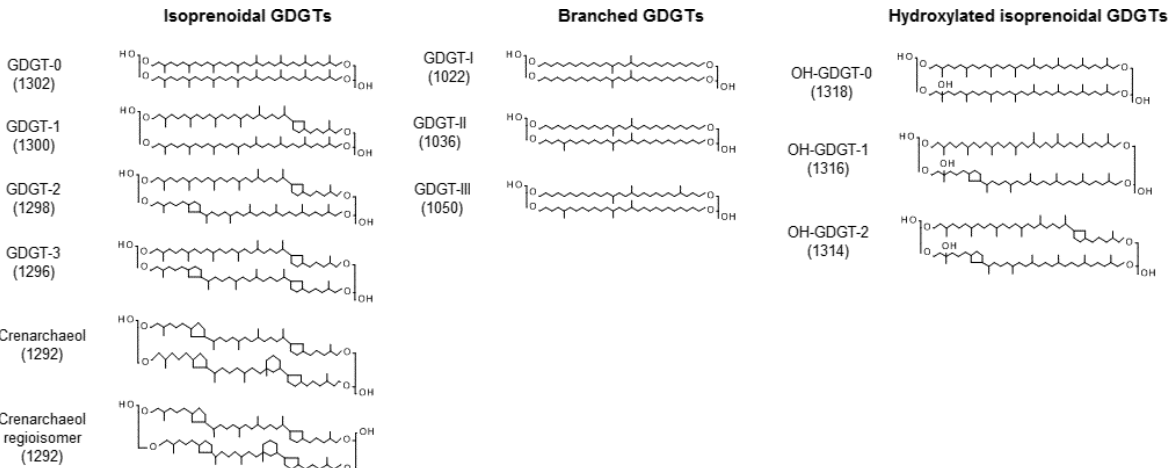
Figure 1. Chemical structures and molecular ion m/z values of the isoprenoid glycerol dialkyl glycerol tetraethers (GDGTs), branched GDGTs, and hydroxylated